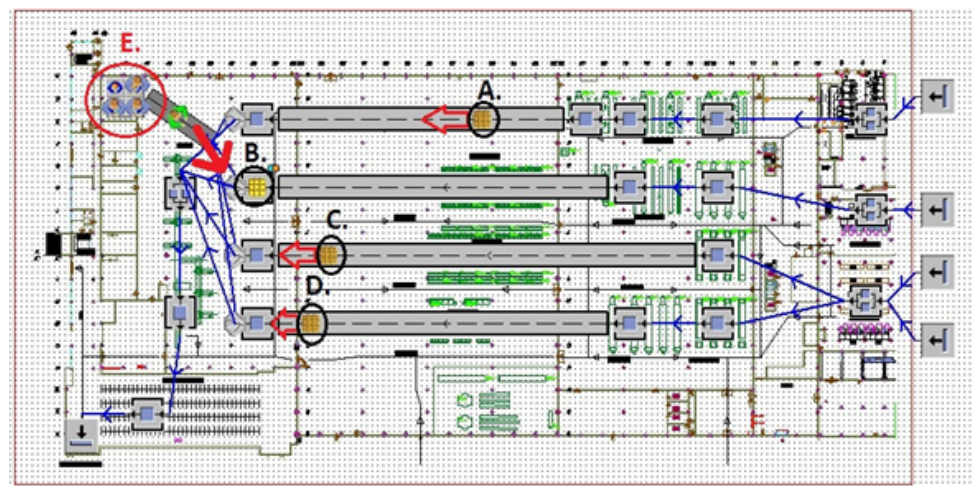
Figure 5. Critical part of the production process.